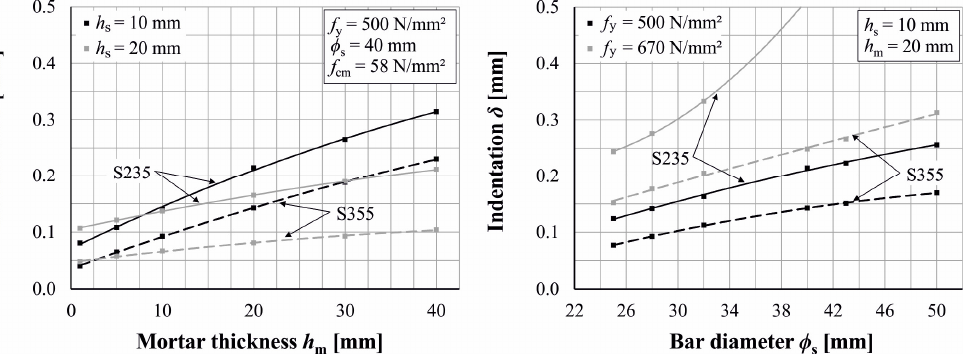
Figure 11. Indentations in relation to mortar thickness ( left ) and in relation to longitudinal bar diameter ( right ).